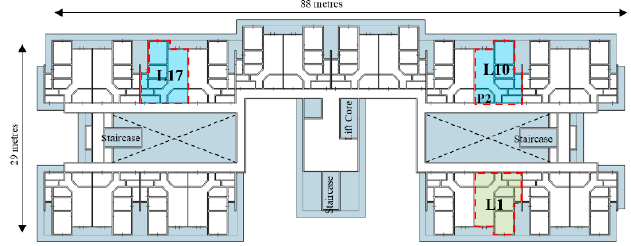
Figure 5. Typical floor plan of the PPR Beringin (First Generation).